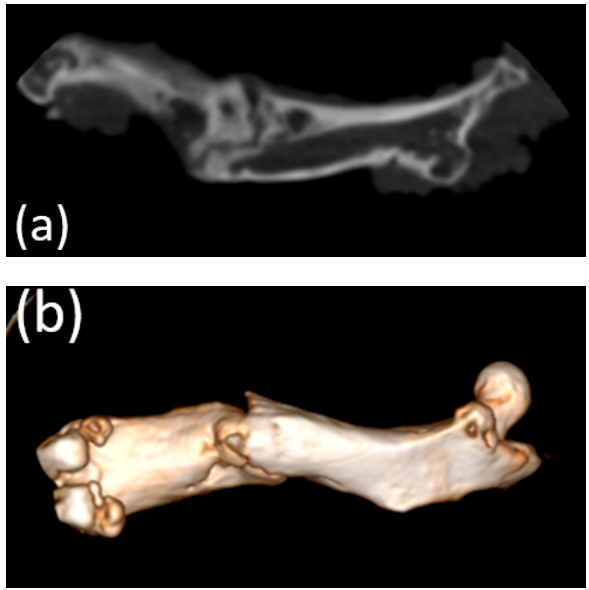
Figure 9. ( a,b ) Image of the femur of an animal 3 months after implantation (obtained with CBCT). Figure 9. ( a , b ) Image of the femur of an animal 3 months after implantation (obtained with